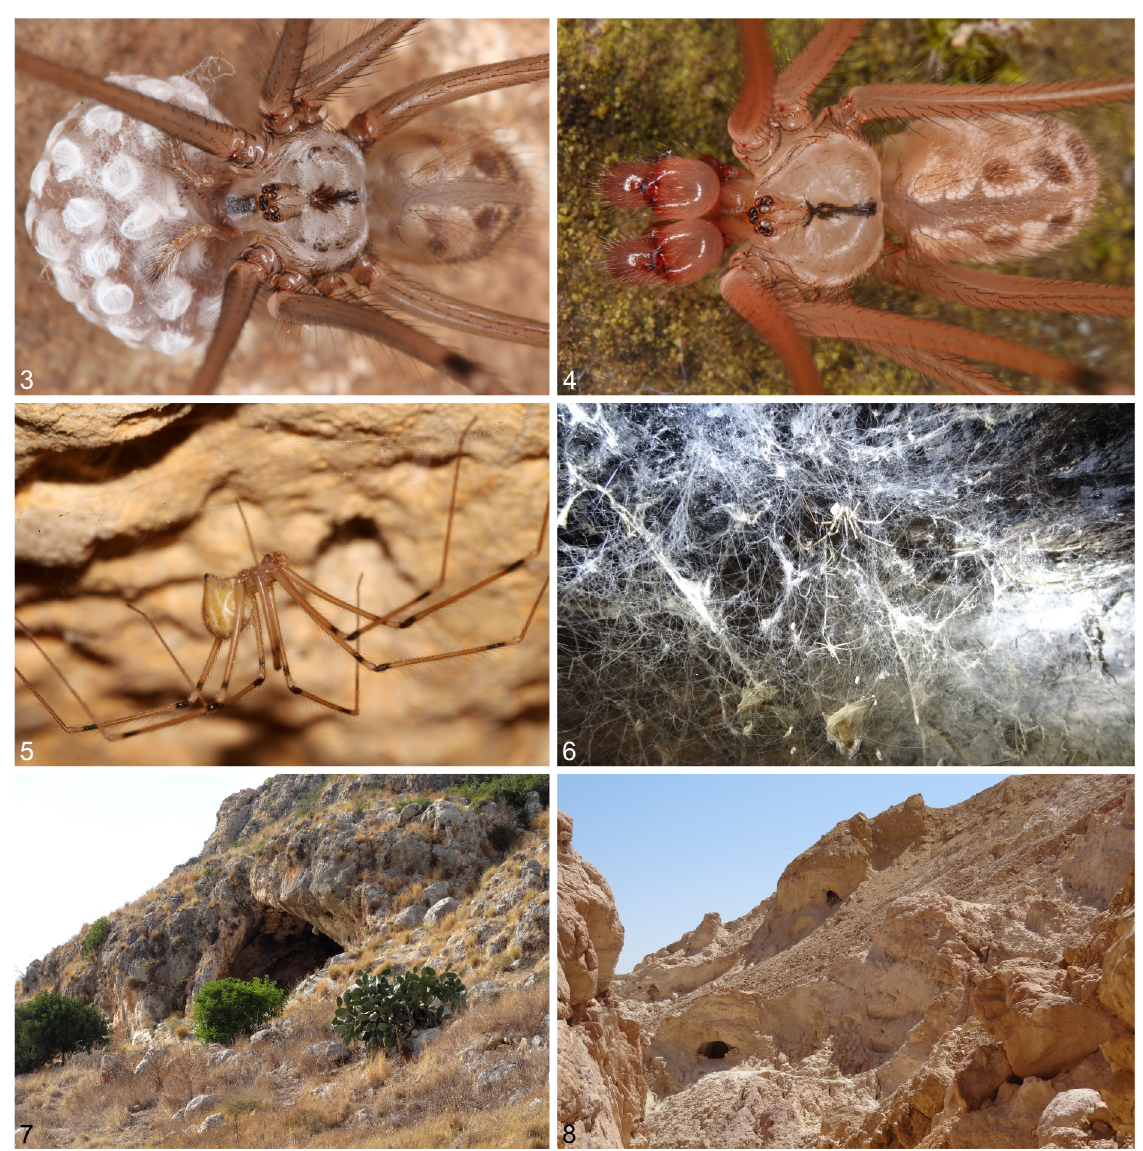
Figs 3–8. Live specimens and habitats. 3 . Artema atlanta Walckenaer, 1837 from Thailand, Ratchaburi. 4–5 . A. nephilit sp. nov. from Israel. 6 . Typical Artema web mass, in a cave in Petra, Jordan. 7–8 . Caves populated by Artema nephilit sp. nov.: Oren Cave, Mount Karmel (7) and caves in the Eilat Mountains (8), Israel. Photos: BAH (3–4, 6–8), SA